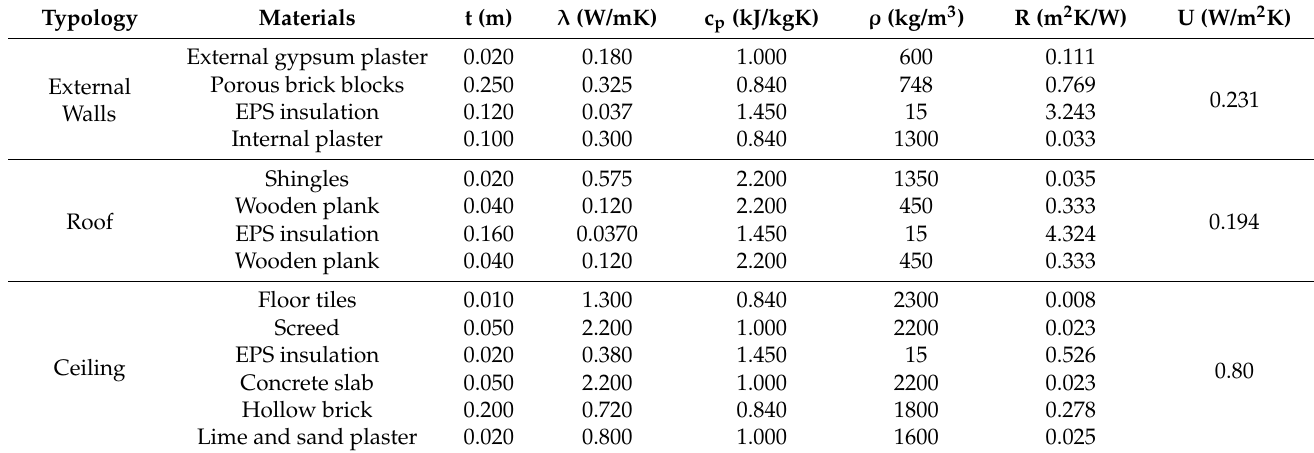
Table 1. Thermal and geometric characteristics of the opaque building envelope.